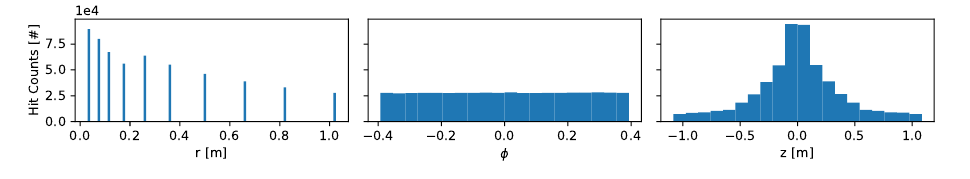
Figure 3. Histogram of hits crated using 1600 subgraphs in cylindrical coordinates. The distribution of r and z can be explained by referring to the geometry of the detector in Figure 1. The distribution in φ is uniform as expected since the geometry is symmetric along the transverse